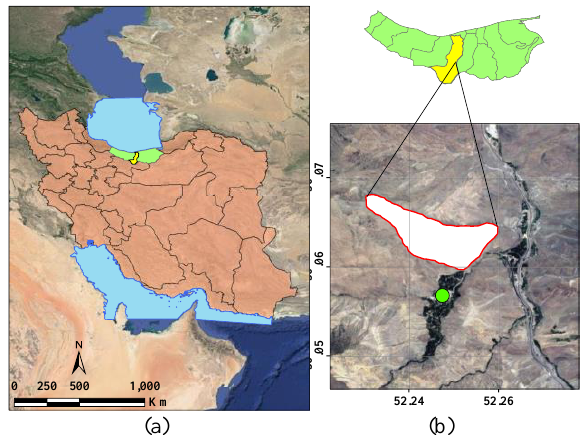
Figure 1. (a) Location of the Mazandaran province in Iran superimposed on the Google-earth image, (b) Kahroud landslide boundary depicted by red polygon. The village of Kahroud is presented by a green circle.